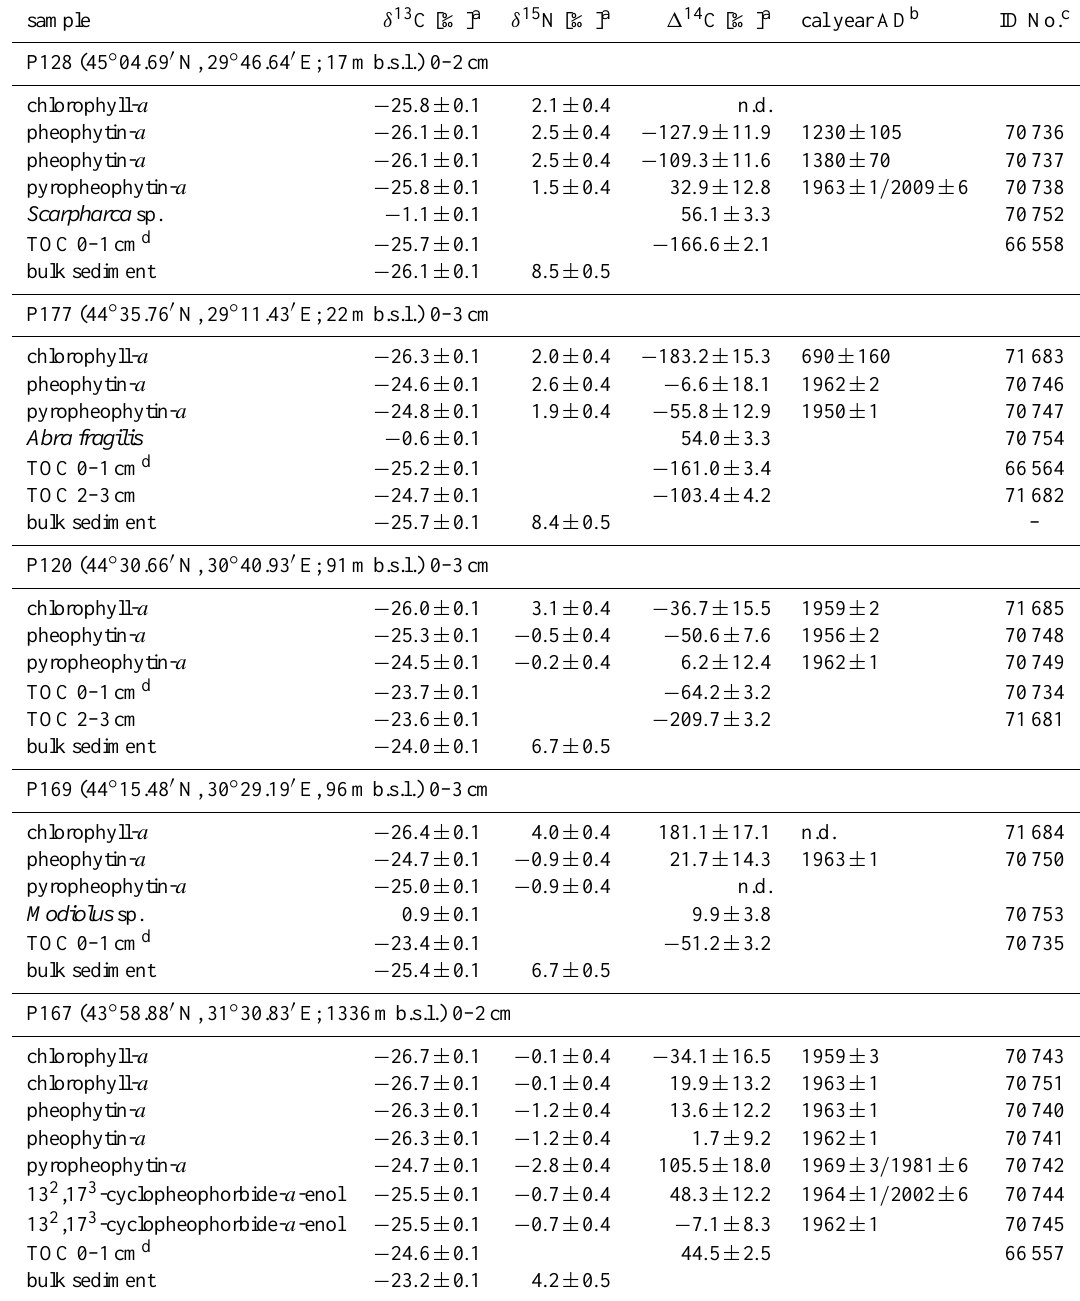
Table 1. Blank-corrected radiocarbon ( 1 14 C) and stable isotopic compositions ( δ 13 C and δ 15 N) of purified chloro- and pheopigments, bivalve shells, total organic carbon (TOC), and bulk sediment. Where sample sizes were sufficient, samples were split prior to 14 C analysis. Errors are given as 1 σ analytical uncertainties. n.d. = not